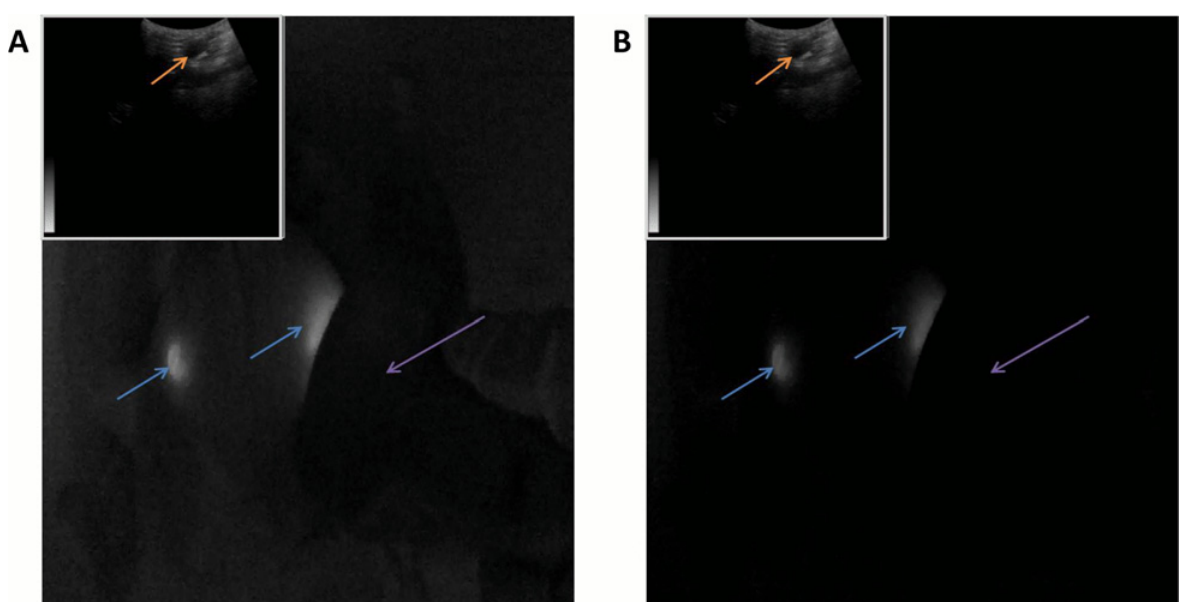
Fig 4. Goggle aided stereoscopic imaging with ultrasound. 2 fluorescent targets (blue arrows) implanted into the chicken breast at depths of approximately 3 mm. Ultrasound imagery is displayed in picture-in-picture mode at the upper left of the goggle imaging frame. The ultrasound transducer (purple arrow) was capable of detecting the implanted fluorescent tube as a dark region (orange arrow), similar to a large vessel or fluid filled sac. Imaging was conducted with (A) and without (B) unfiltered NIR